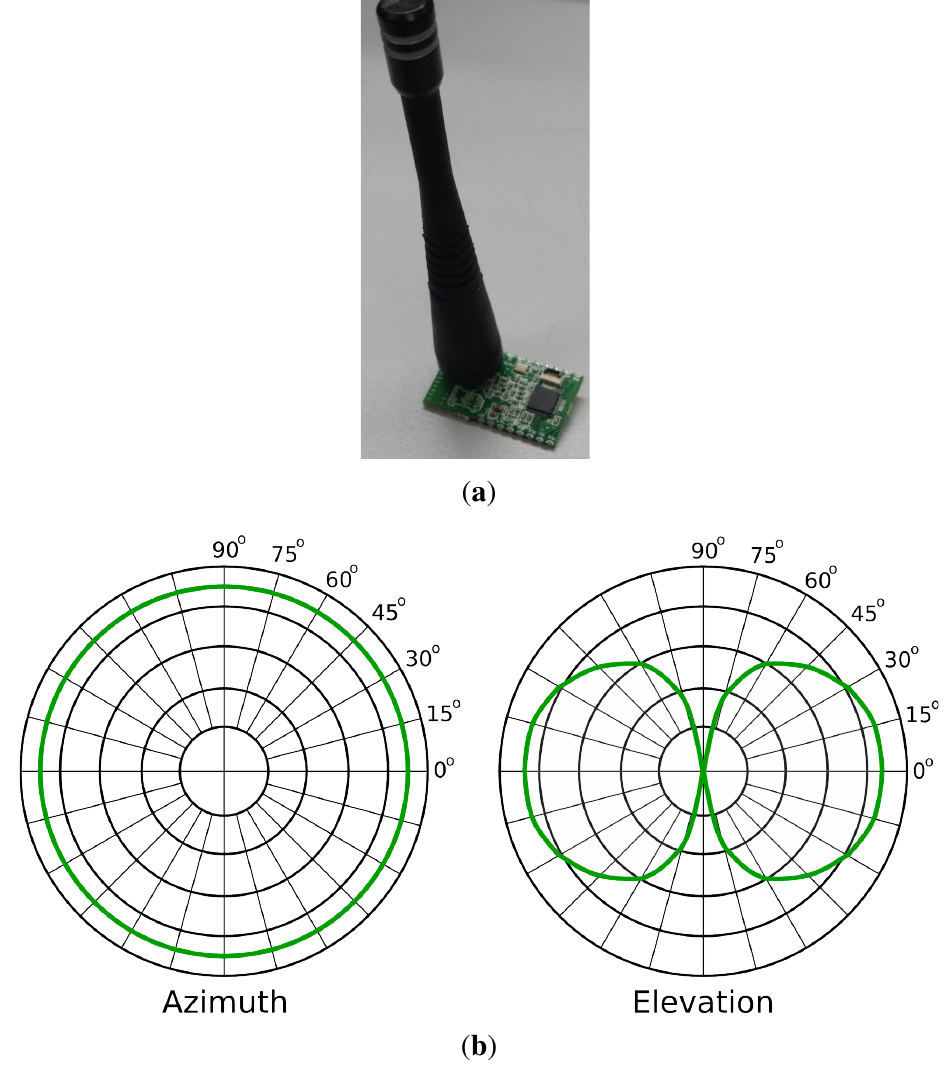
Figure 1. ( a ) Prototype of a mote using a CC1110 sub-1-GHz SoC with a monopole antenna; ( b ) radiation pattern of the monopole antenna for an arbitrary transmission